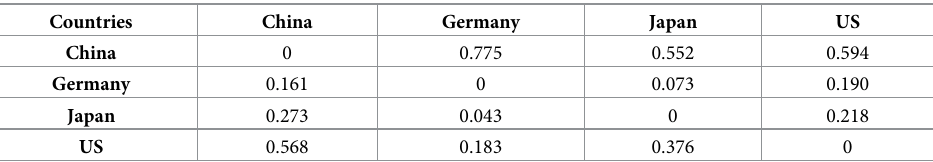
Table 6. Trade weight matrix.